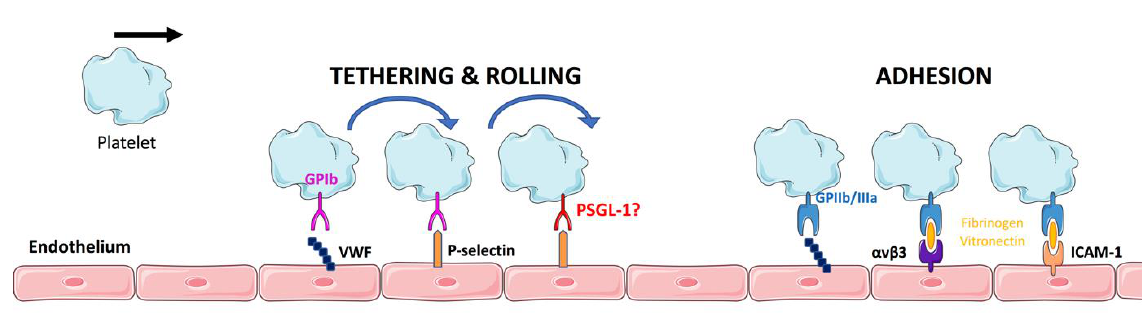
Figure 4. Platelet rolling and adhesion to the vascular